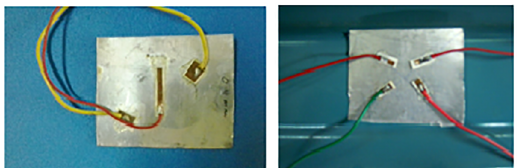
Figure 2. The fixation of antenna randomly for Antenna to capture EMR